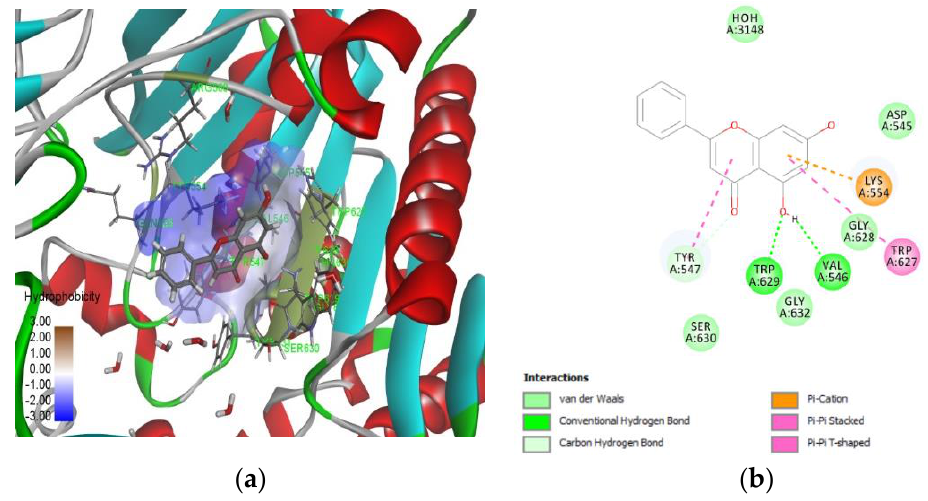
Figure 3. The three-dimensional view, representing the binding pose view of chrysin: at the active site of the DPP-4 enzyme ( a ); and ( b ) a two-dimensional representation of interacting residues from the DPP-4 enzyme, involved at binding pose of chrysin.